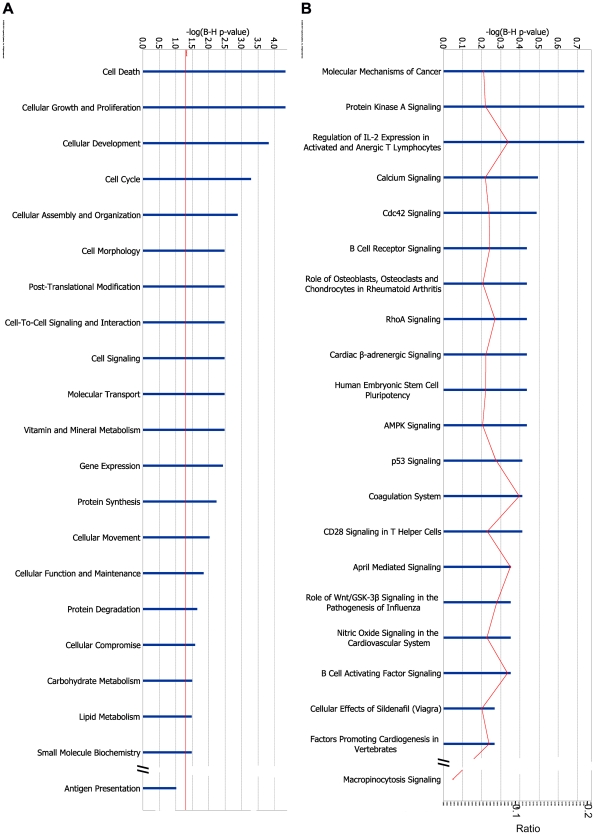
IPA of changes in alternative splicing induced by cytokines.IPA of genes with AS modified by IL-1β+IFN-γ. 425 transcripts were significantly up-regulated in at least 4 out of 5 islet samples and significantly downregulated in none, and 433 transcripts were significantly downregulated using similar criteria. These transcripts could be mapped by RefSeq ID to 546 genes. IPA of these genes for (A) “Molecular and Cellular Function” and (B) “Canonical Pathways”. The length of the blue bars indicates the significance of the association between the set of transcripts and the keyword, and is expressed as minus the logarithm of the probability that a random set of transcripts from the human genome would be associated with the same keyword. The straight red line indicates a threshold of 0.05 (corresponding to a −log(B–H p-value) of 1.3). The curved red line indicates for each pathway the ratio between the number of transcripts observed in the data set and the total number of transcripts in the pathway (as annotated in IPA).